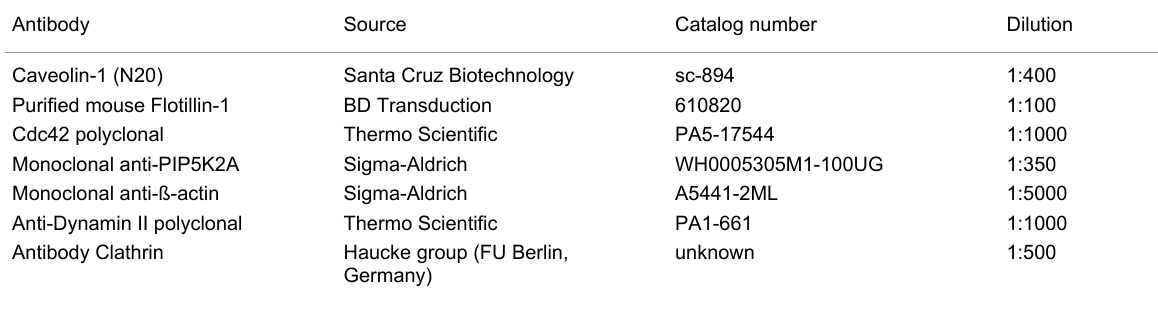
Table 4: Primary antibodies with source and dilution used for detection of target proteins.